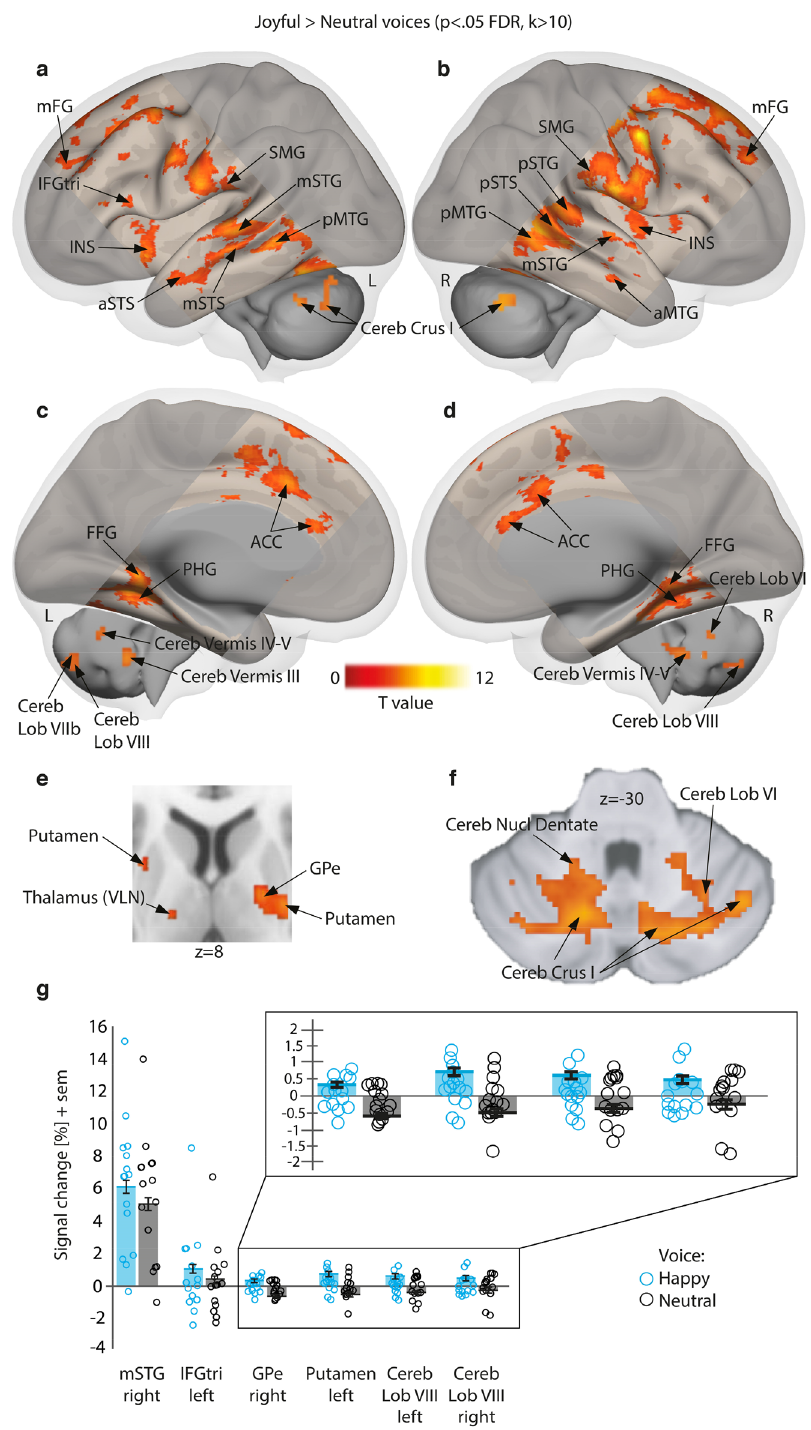
Figure 2. Enhanced brain measures for implicitly processing happy compared to neutral voices, corrected for multiple comparisons (wholebrain voxel-wise p < .05 FDR, k > 10 voxels). ( a – b ) Lateral activations rendered on a sagittal image highlighting middle, superior temporal and cerebellar regions. ( c – d ) Medial activations of the anterior cingulate cortex, parahippocampal cortex and cerebellum. e Subcortical activity in the putamen, thalamus and globus pallidus displayed on an axial slice. ( f ) Cerebellar activations displayed on an axial slice. ( g ) Percentage of signal change extracted using singular value decomposition on 9 voxels around each peak in a subset of regions with individual values (circles), mean values (bars) and standard error of the mean (error bars) for happy and neutral voices. Blue circles: happy voices; Black circles: neutral voices. L: left; R: right; IFGtri: inferior frontal gyrus triangularis part; STG: superior temporal gyrus; STS: superior temporal sulcus; MTG: middle temporal gyrus; INS: insula; SMG: supramarginal gyrus; FG: frontal gyrus; FFG: fusiform gyrus; PHG: parahippocampal gyrus; ACC: anterior cingulate cortex; Cereb: cerebellum; Cereb Lob: cerebellum lobule; Cereb Nucl Dentate: dentate nucleus of the cerebellum; Brainstem LL: lateral lemniscus of the brainstem; Thalamus VLN: ventral lateral nucleus of the thalamus; GPe: external globus pallidus; Cereb Crus: cerebellum crus of ansiform lobule; ACC: anterior cingulate cortex. ‘a’ prefix: anterior part; ‘m’ prefix: mid part; ‘p’ prefix: posterior